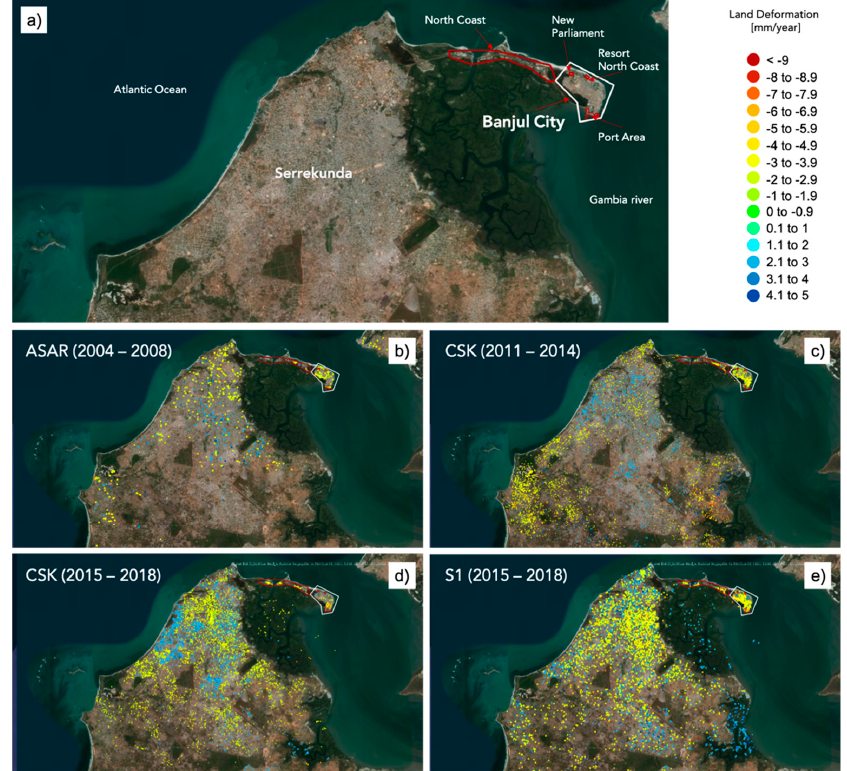
Figure 11. Land deformation results for Banjul, the Gambia, obtained using ASAR data for the period 2004–2008 ( b ), COSMO-SkyMed data for 2011–2014 ( c ) and 2015–2018 ( d ) and Sentinel-1 data for 2015–2018 ( e ). Points showing deformation between − 2 and 2 mm/year were fi ltered out of the image as they are considered noise. Five AOIs were considered for detailed analysis, as shown in ( a ): Banjul city, new Parliament, port area, resort north coast and north